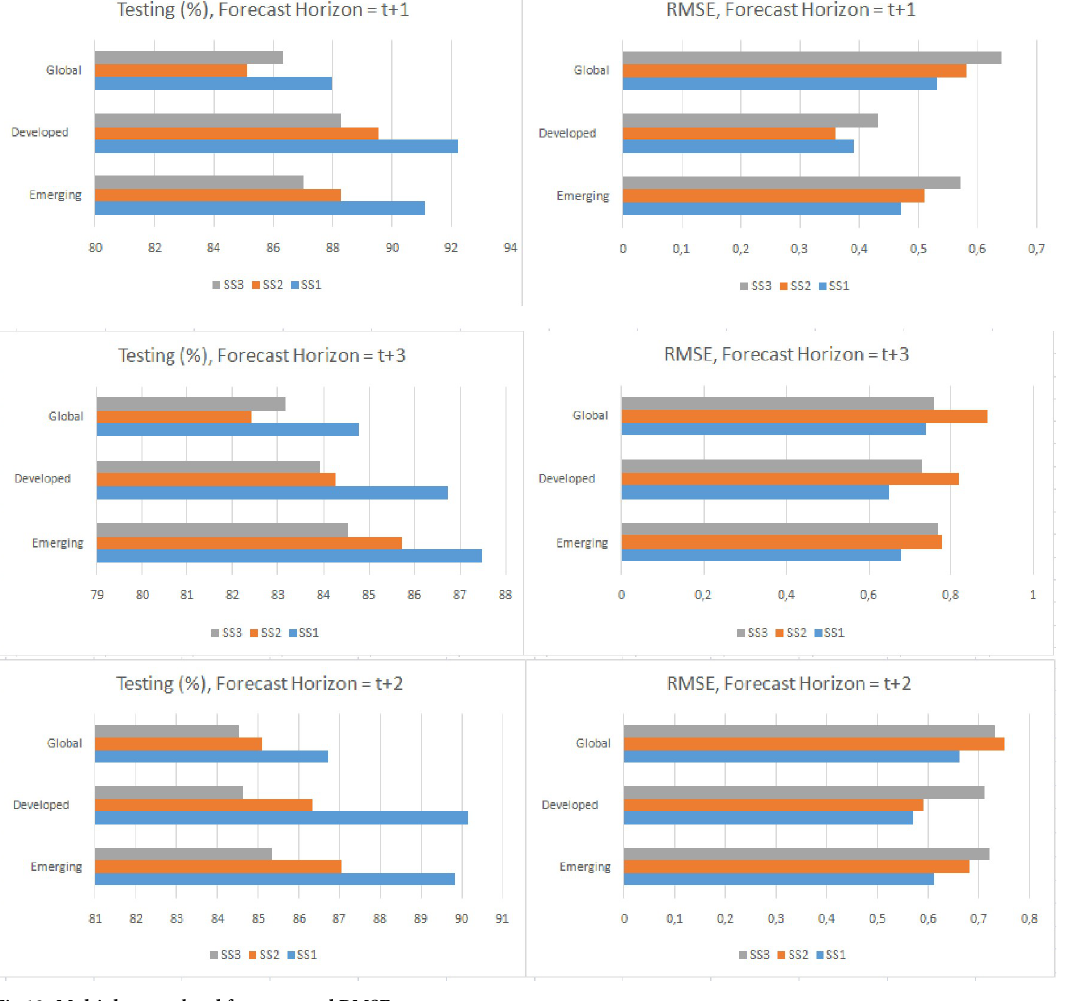
Fig 10. Multiple-step ahead forecasts and RMSE